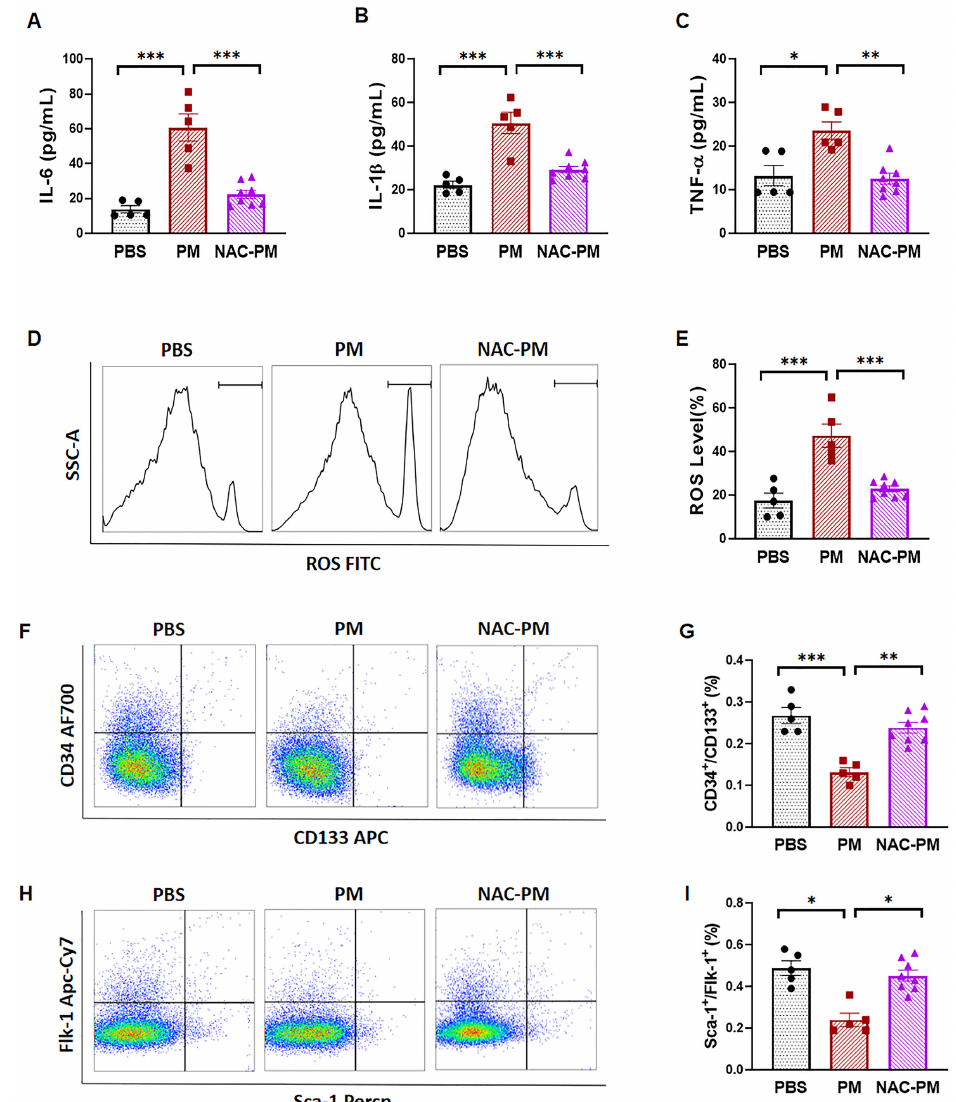
Figure 3. NAC preserved the circulating EPCs in male mice with PM exposure. ( A–C ) The elevated serum levels of pro-inflammatory cytokines IL-6 ( A ), IL-1 β ( B ), and TNF- α ( C ) induced by PM were effectively prevented by NAC treatment. ( D ) Increased ROS production exposed to PM was also blocked by NAC treatment. ( E ) Quantification data from (D). ( F–I ), Flow cytometry analysis for circulating EPCs (CD34 + /CD133 + ) or (Sca-1 + /Flk-1 + ), with summary data ( G,I ) showing that the PM exposure-induced decrease in the circulating EPC level in male mice was restored after NAC treatment. PBS: male mice with PBS treatment ( n = 5); PM: male mice with PM exposure ( n = 5); NAC-PM: male mice with PM exposure and NAC treatment ( n = 8). * p < 0.05, ** p < 0.01, and *** p < 0.001.